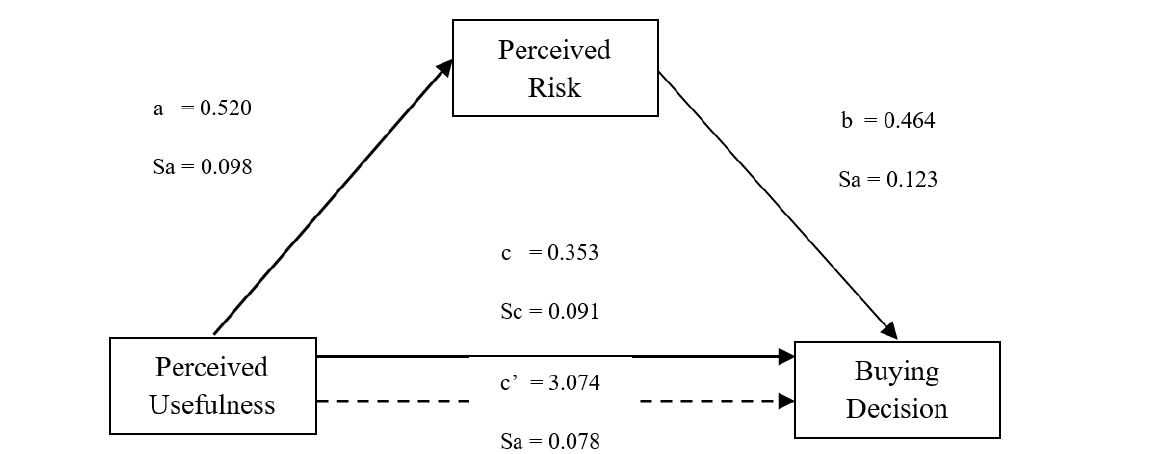
Fig. 5. The mediating role of perceived risk in the relationship between perceived usefulness and consumer buying